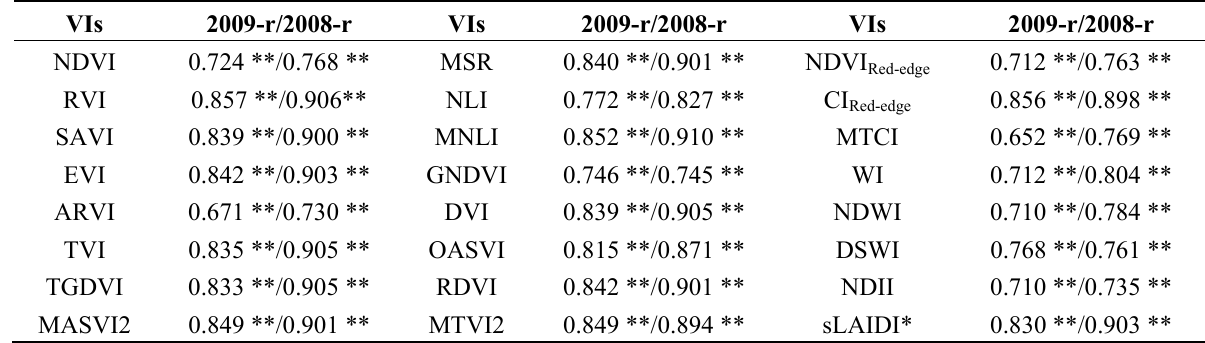
Table 6. Correlation between vegetation indices and LAI in different